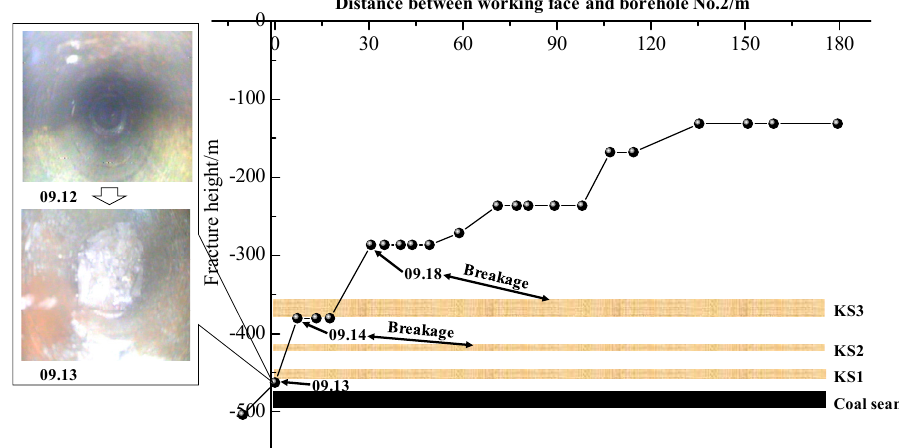
Figure 4. Fracture height curve recorded by the borehole TV tester.